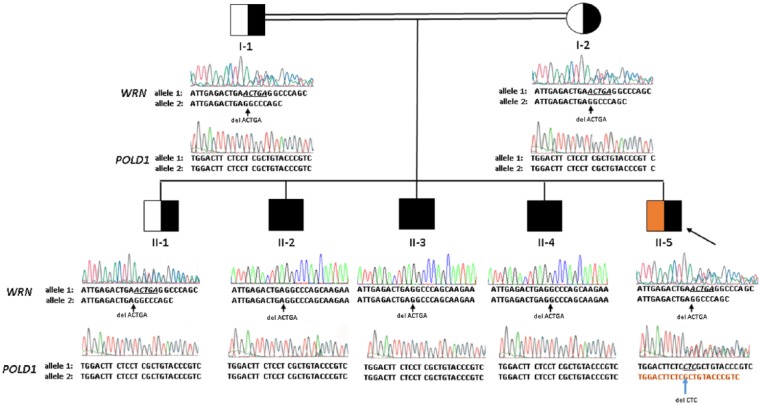
Pedigree showing proband (II-5, large arrow) in relation to parents (I-1, I-2) and 4 brothers (II-1 through II-4).Males and females are squares and circles, respectively. Consanguinity is indicated by double lines. Black shading indicates the genotype status for the WRN variant (half- and whole-filled symbols are heterozygotes and homozygotes, respectively). Orange shading indicates the genotype status for the POLD1 variant (half-filled symbol is a heterozygote). Below each individual, Sanger sequence electropherogram tracings for WRN and POLD1 are shown; nucleotide calls for each allele are shown beneath the sequence tracings. Individuals I-1, I-2, II-1, and II-5 each have a heterozygous genotype for WRN p.Thr307Thr fsX5, consisting of one wild-type allele with normal sequence and one frameshifted allele due to the deletion of 5 base pairs, indicated by small arrows and reflected in the reduced intensity and mixed colors of peaks following the deletion. Individuals II-2, II-3, and II-4 are homozygous for this mutation. Similarly, the tracings for the affected region of the POLD1 gene are shown; all individuals except for II-5 are homozygous for the normal wild-type sequence, while individual II-5 has a de novo heterozygous in-frame deletion of 3 nucleotides, involving codon 605; the mutation is designated as POLD1 p.Ser605del and its position is indicated by the small arrow.